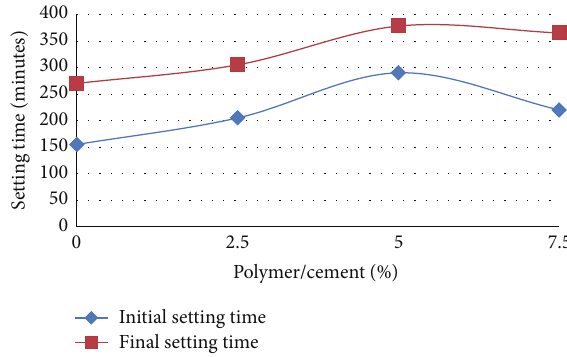
Figure 2: The setting time of polymer modified cement paste with 0%